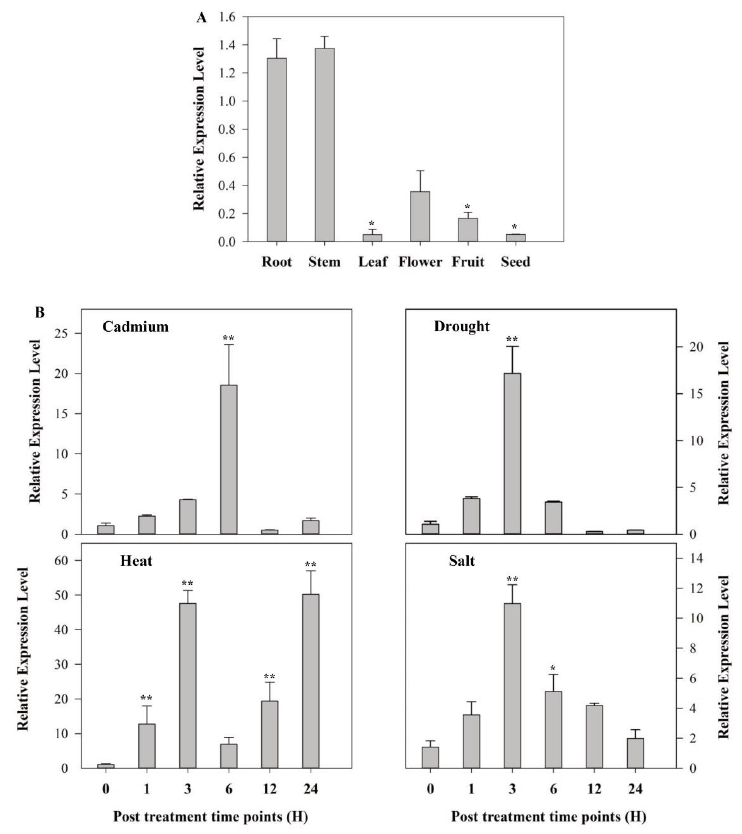
Figure 1. Transcript levels of SlMAPK3 in tomato as influenced by different tissues types and abiotic stressors. ( A ) SlMAPK3 expression in different plant tissues, and ( B ) time course of SlMAPK3 transcript under abiotic stresses induced by cadmium (150 μM CdCl 2 2.5H 2 O), drought (dehydration), heat (40 °C) and salt (200 mM NaCl). Data represent mean ± SE of three biological replicates. **, * significant level differed at p < 0.01 and p < 0.05, respectively.